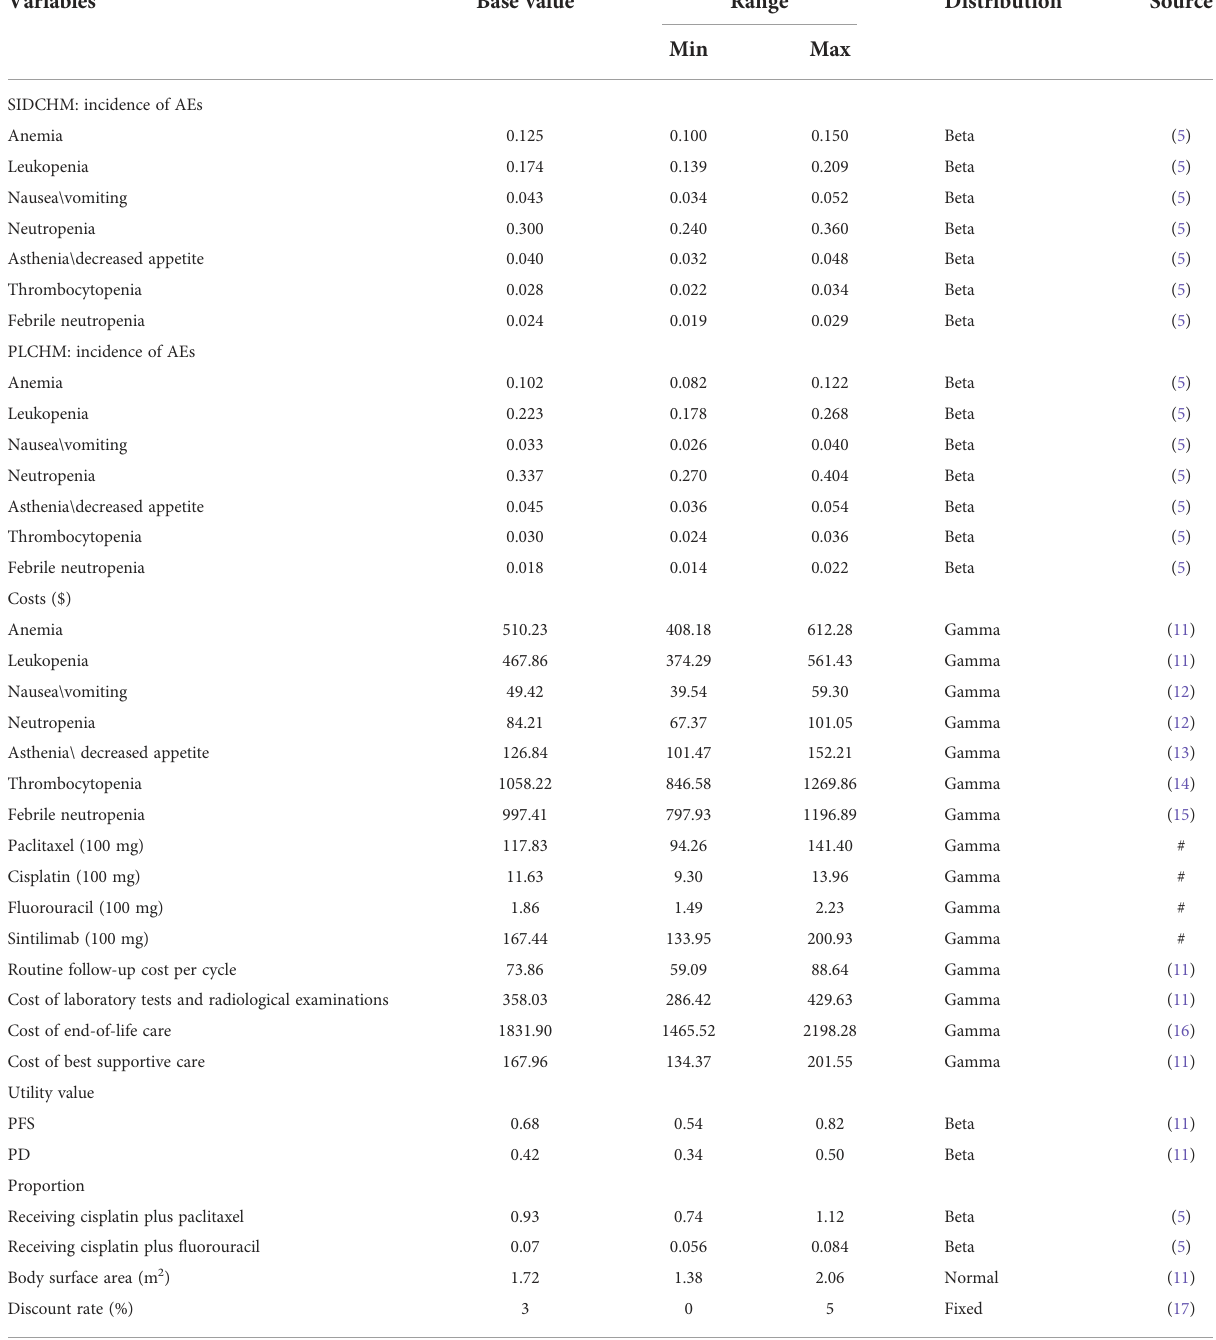
TABLE 2 The basic parameters of the input model and the range of sensitivity analyses. Variables Base value Range Distribution Source Min